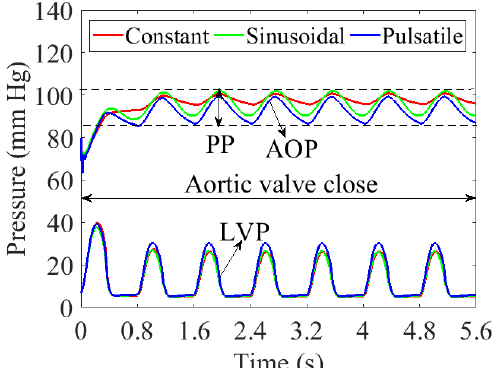
Figure 9. Changes in LVP and AOP when the left ventricle was assisted by the three kinds of speed patterns of the blood pump. The pressure difference between the dotted lines represents the maximum aortic pulse pressure (PP) As LVP was much lower than AOP, the aortic valve remained closed during the process of blood pump assistance.